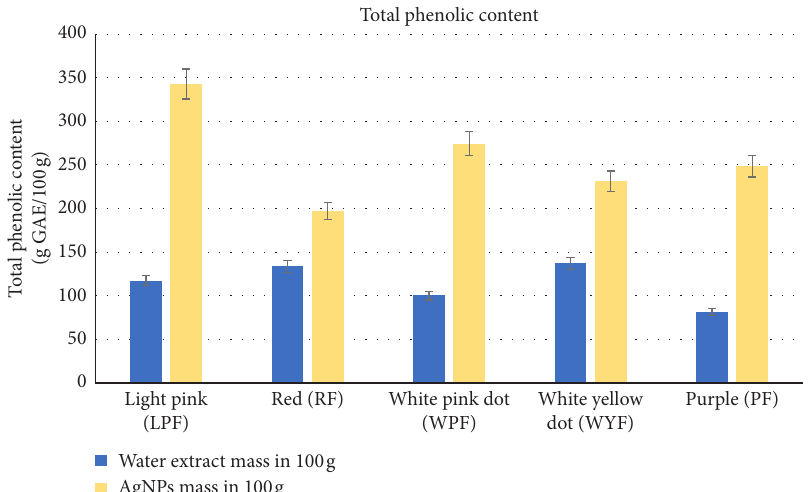
Figure 12: Total phenolic content of water extracts and AgNPs expressed as gallic acid equivalents